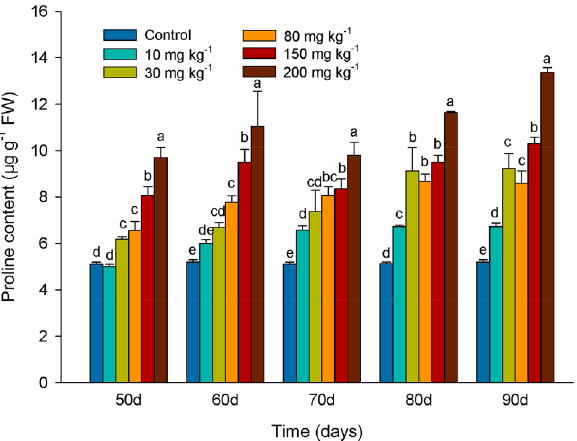
Figure 4. Proline levels in leaves of Lonicera japonica Thunb. cuttings exposed to different concentrations of Cd. Different letters indicate a significant difference ( P < 0.05) based on Duncan’s multiple range test at 5% level. Values are the mean ± SD (n =